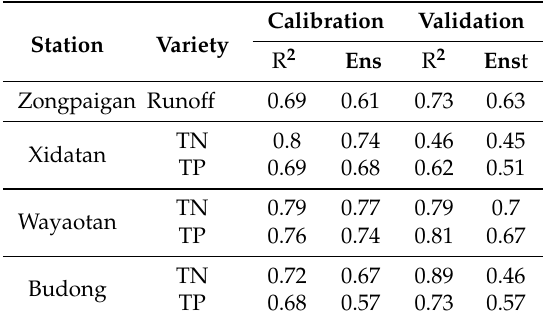
Table 2. Evaluation of the simulation results of monthly TN and TP during calibration and validation